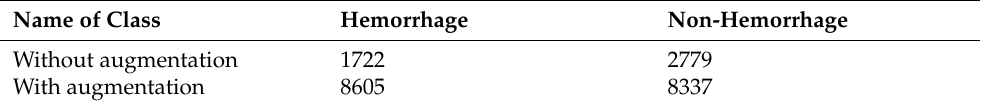
Table 2. Using the data augmentation method to overcome the overfitting and balancing of the dataset. Name of Class